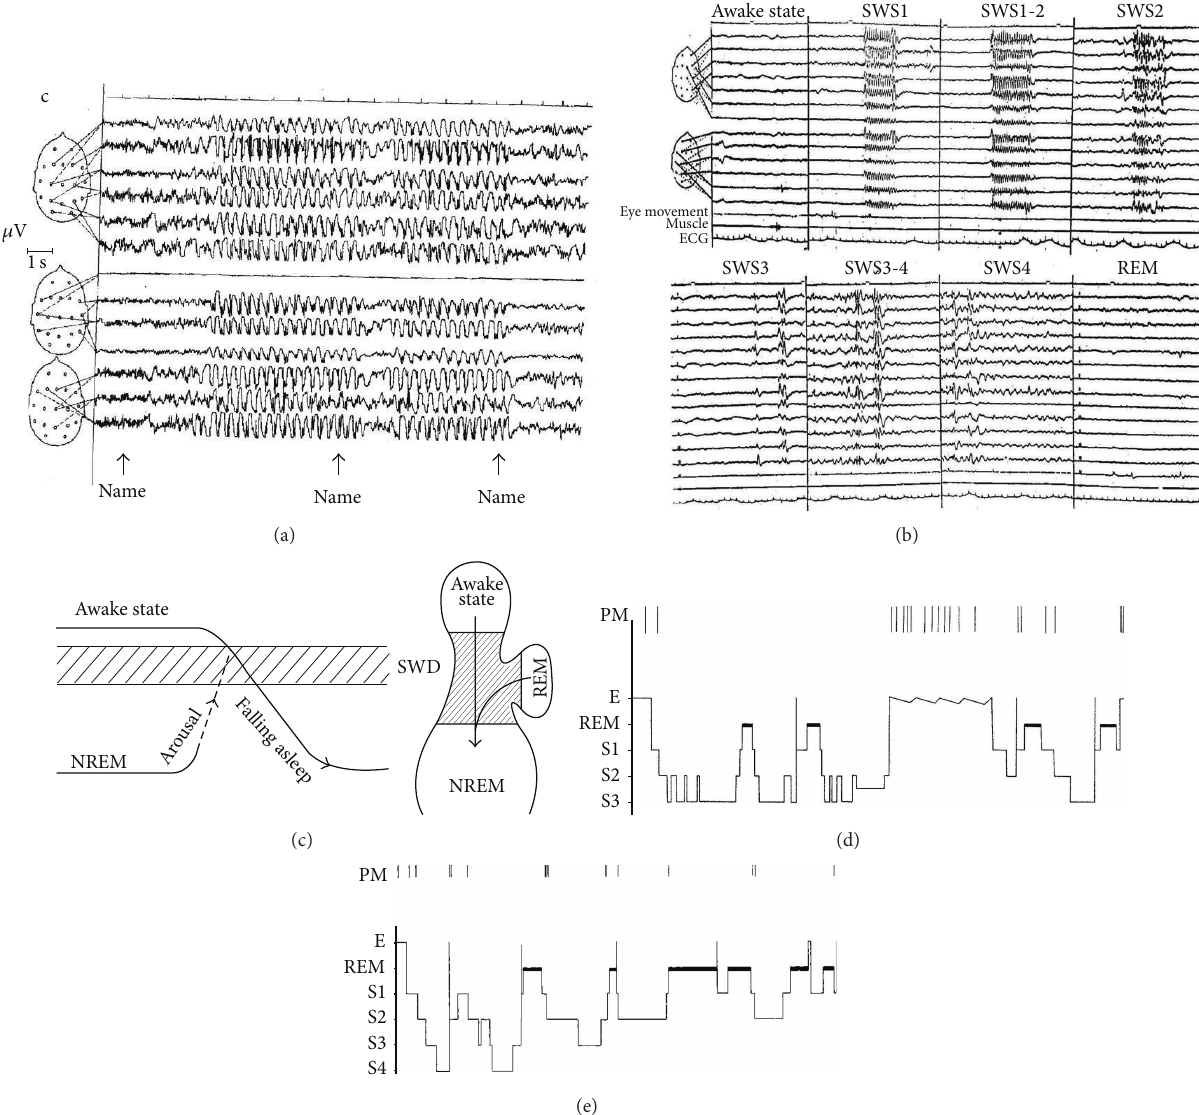
Figure 1: Distribution of generalized spike-wave discharges in different vigilance levels. (a) and (b) In absence epilepsy elevating the vigilance level from NREM sleep by calling the name of the patient first results in transitory activation of the discharges, and later the application of the same stimulus inhibits the discharges. As seen in (c) insert shows the optimal decrease of vigilance level which activates the discharges, while increased arousal and deepening of sleep equally inhibit them. The critical vigilance territory is situated between sleep and wakefulness and NREM and REM, as shown in the left insert. The highest activation have been experienced in shifts from wakefulness to NREM sleep and from REM to NREM sleep (arrows). (b) Shows the typical patterns of spike-wave activation during night sleep. During full wakefulness and REM the spike-wave discharges are absent. During the course of falling asleep (stage 1, superficial stage 2) spike-wave discharges show the ictal absence type activation (even if in awake state they were not present). In deeper sleep (stages 3-4) the typical 3Hz spike-wave pattern became disrupted; later we see more polyspike-wave forms. (d) and (e) are typical spike-wave activation conditions in absence epilepsy in two patients: in falling asleep, in transitions from wake to NREM or from REM to NREM, around transitory awake state, and before and after awakening in the